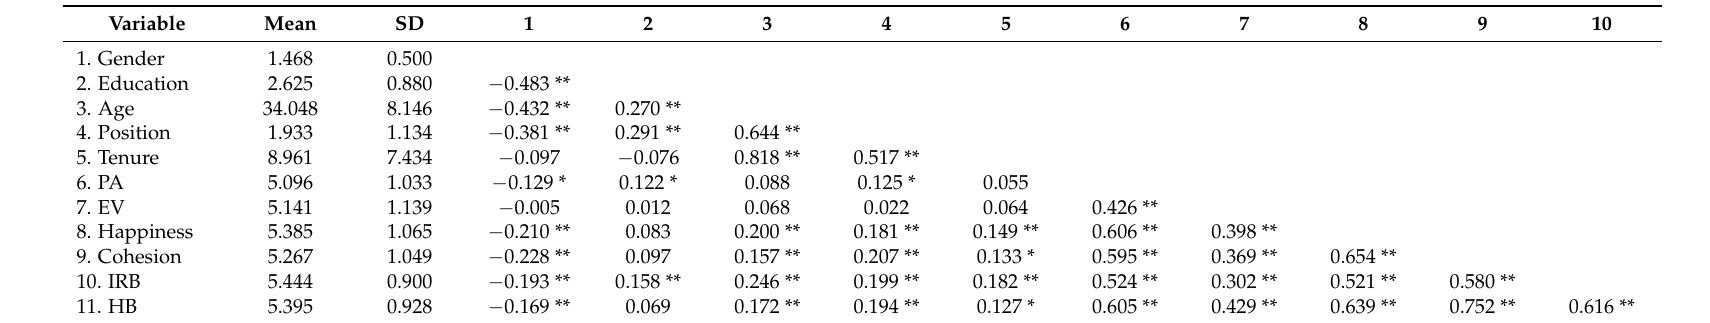
Table 1. Descriptive statistics and zero-order